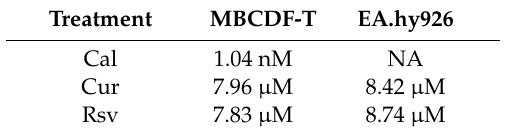
Table 1. Inhibitory concentrations values at 50% (IC 50